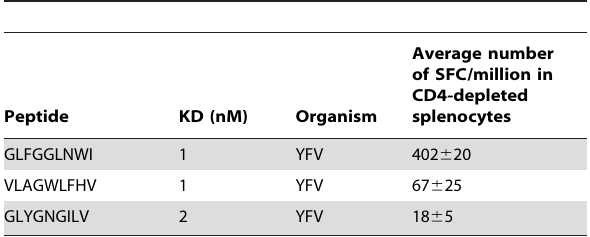
Table 5. ELISPOT results on 17DD YFV vaccine-immunized A*02:01 mice.